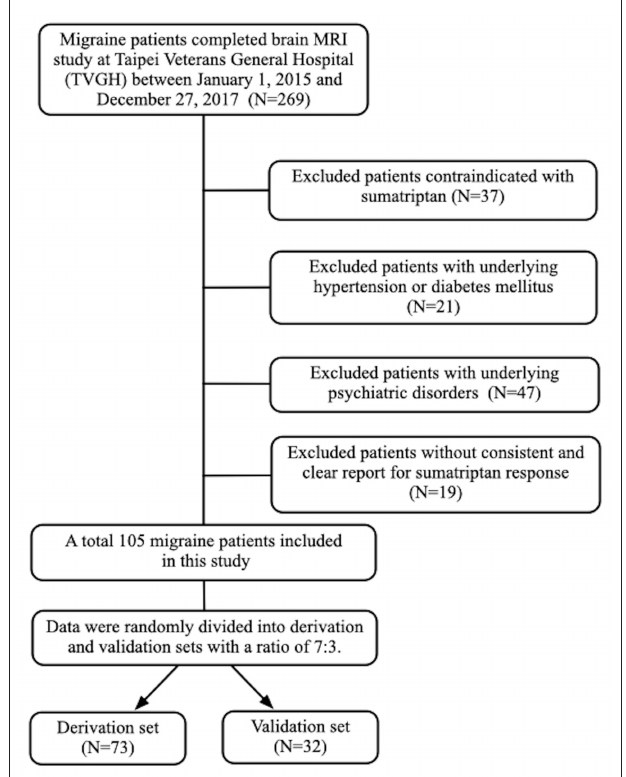
FIGURE 1 | Study schematic flow